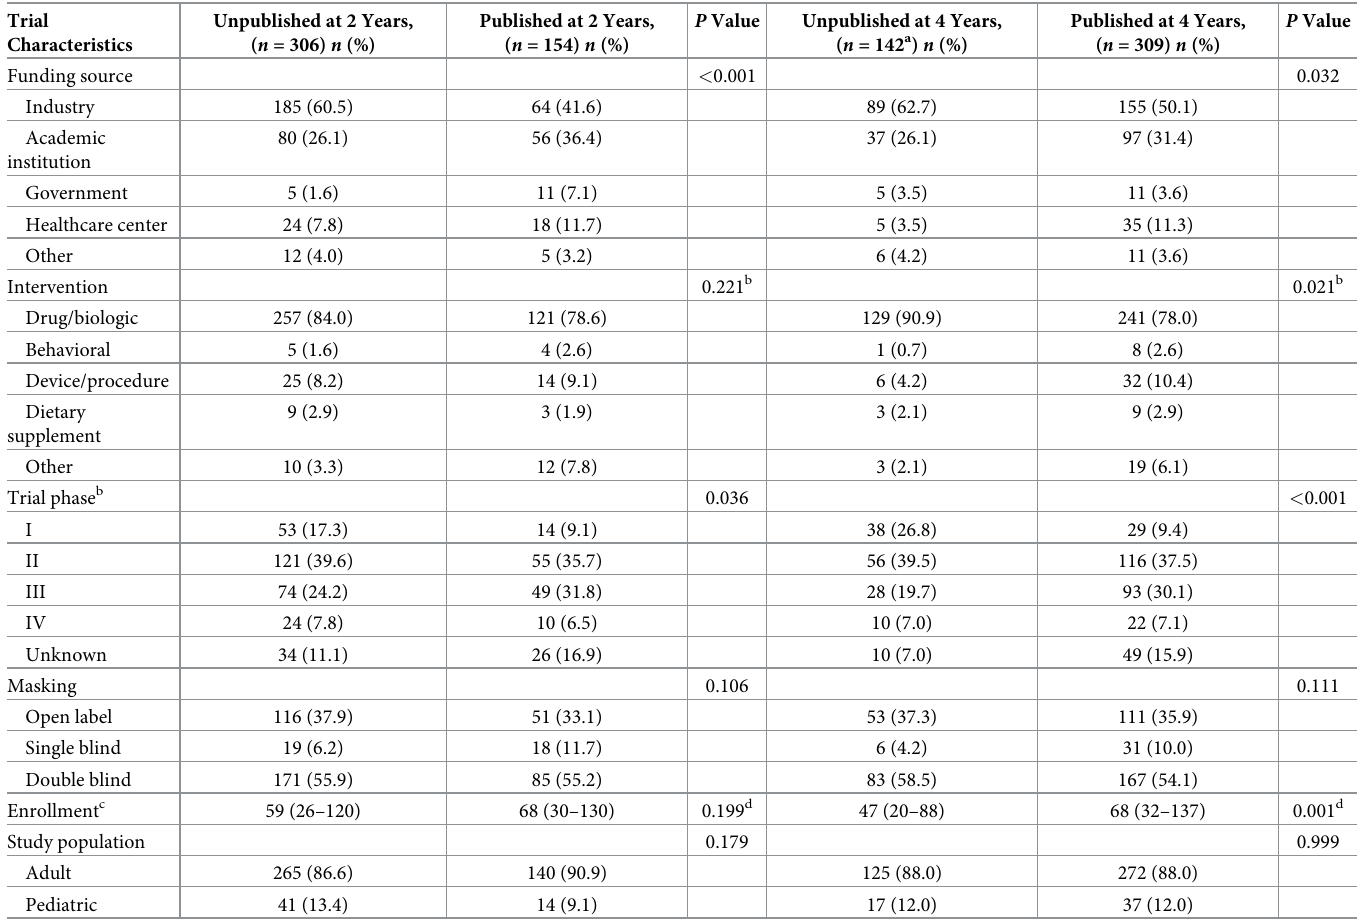
Table 5. Characteristics of published and unpublished rare disease trials that were completed a . Trial